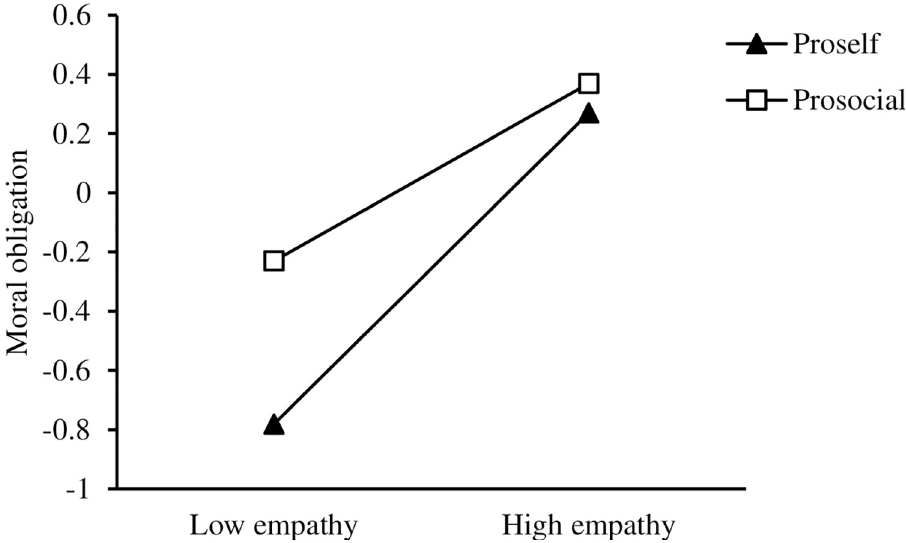
Fig 2. Interaction between empathy and social value orientation on moral obligation.